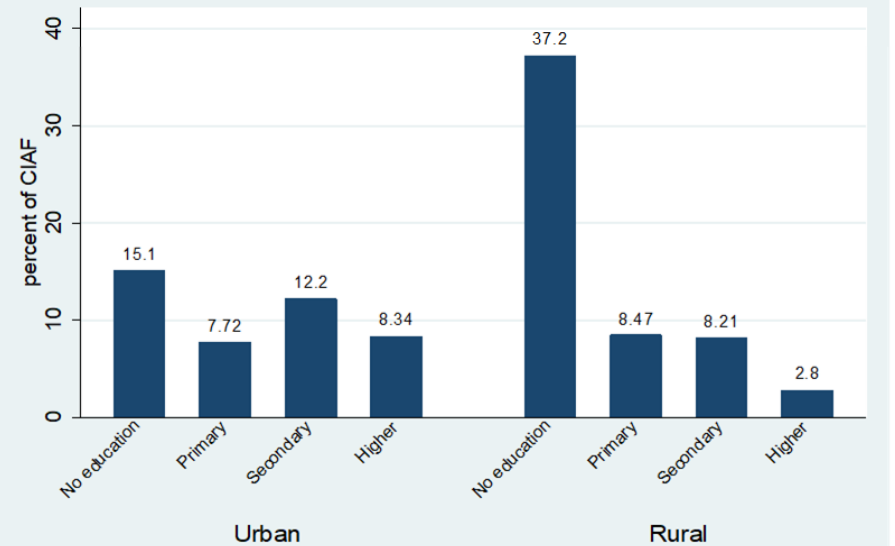
Figure 1. Type of Residence, Gender and Prevelance of Malnutrition.